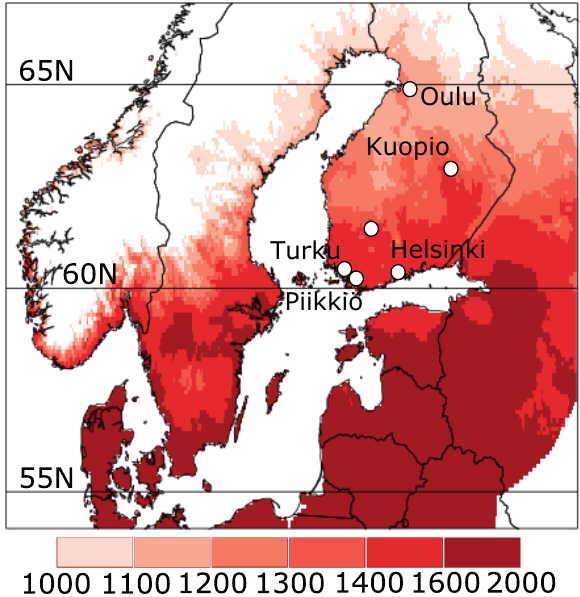
Fig. 1. Median of degree-days (ETS) 1999–2018 (base temperature 5